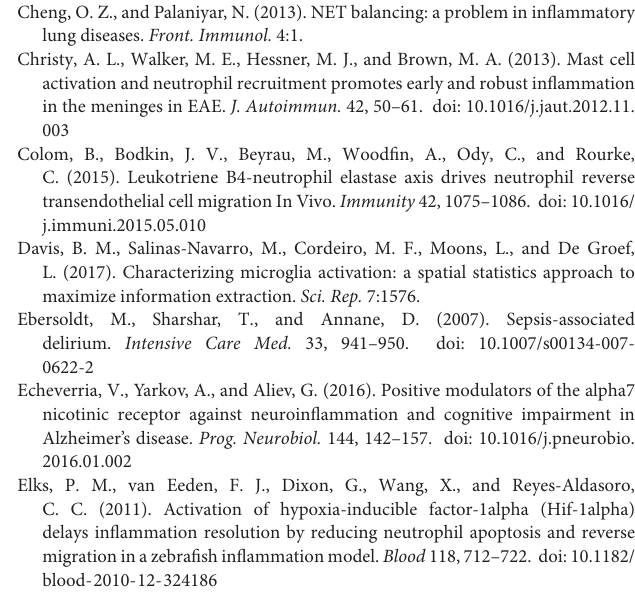
Supplementary Figure 1 | Cranial window surgery setup for brain intravital imaging. (A) Brain chambers with heating plates for maintaining body temperature at 37 ± 0.5 ◦ C. a. Metal and rubber heating plates, b. DC temperature controller, c. Stereotactic instrument for cranial window surgery, d. Head fixation device for imaging. (B) Subsidiary tools for surgery a. cotton swab, b. air blower, c.